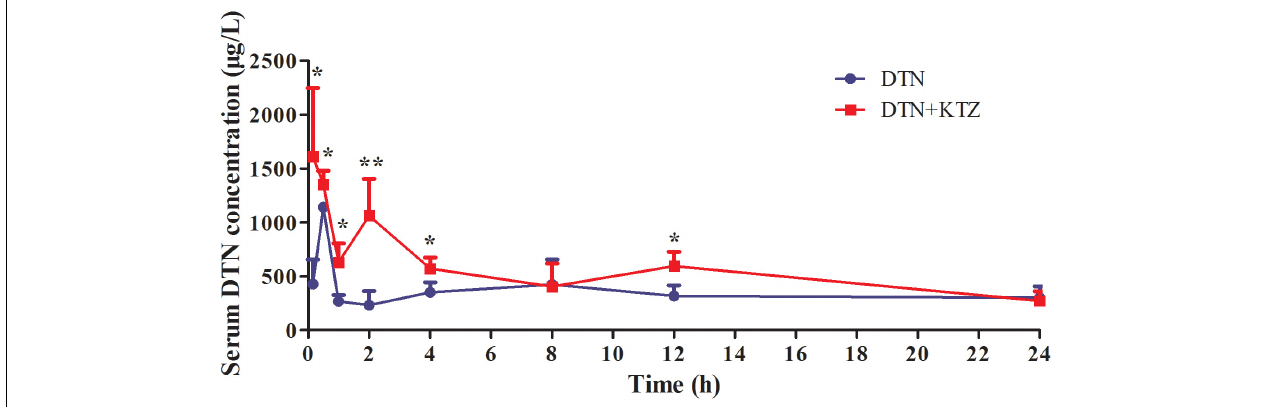
FIGURE 10 | Time-course of measured DTN serum concentrations in mice following oral administration of DTN (320 mg/kg for 4 days and 640 mg/kg on the 5th day) with or without KTZ (75 mg/kg) pretreatment before the last administration. Data are represented as mean ± SD ( n = 4). ∗ p < 0.05, ∗∗ p < 0.01 vs. DTN group.